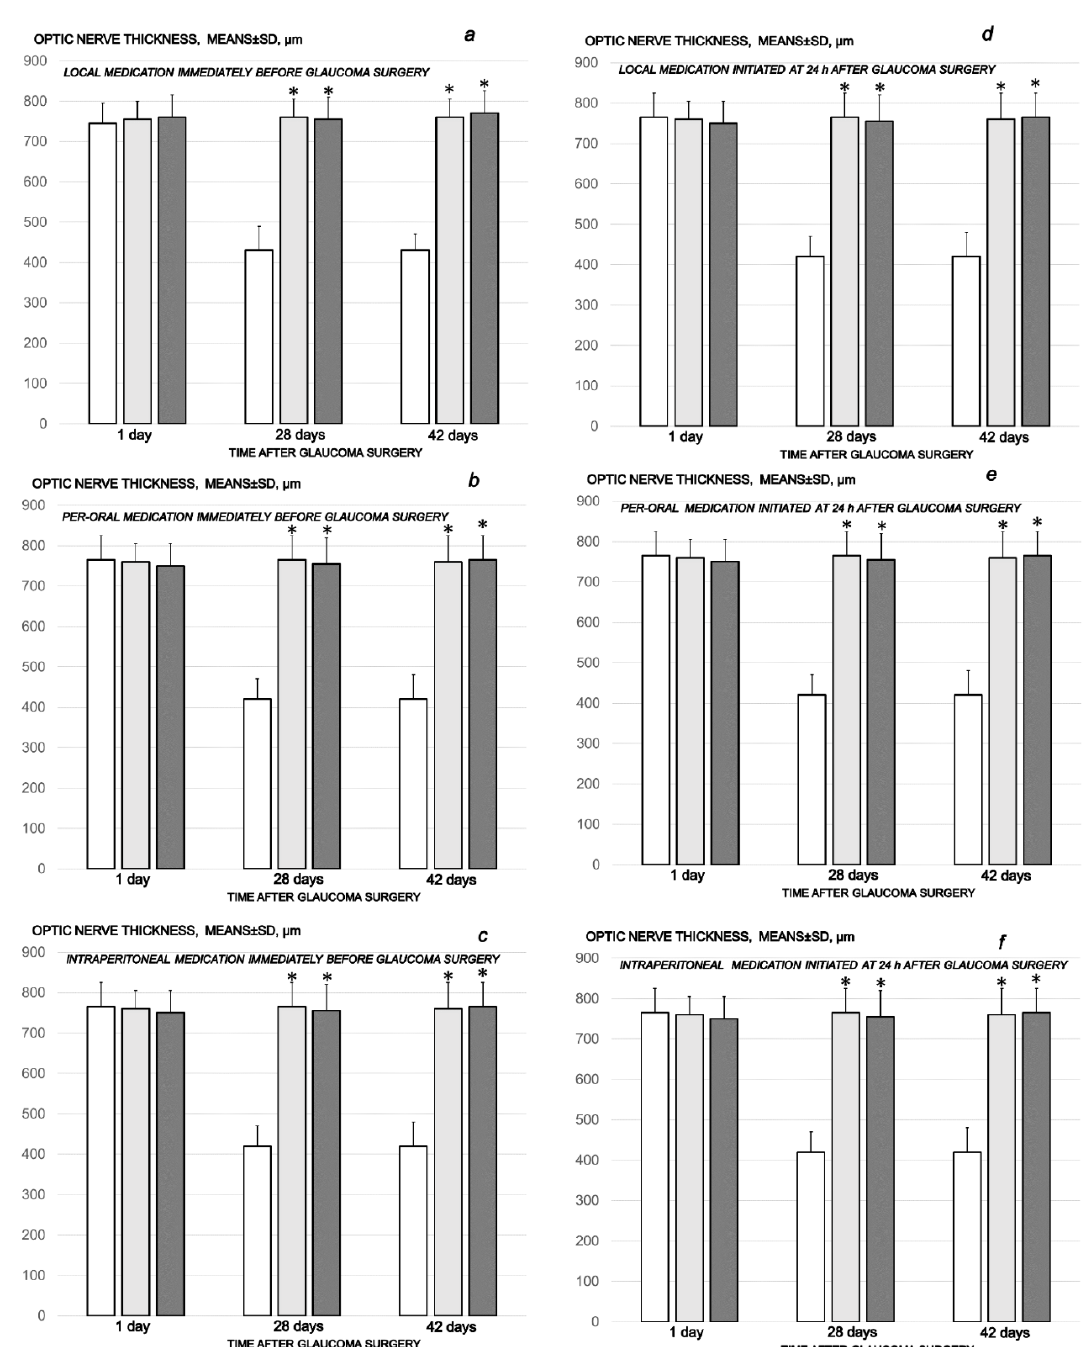
Figure 12. Cauterization of the three episcleral veins induced a decrease in optic nerve thickness, means ± SD, µ m, at the first post-operative day and at the end of the fourth and sixth post-injury week. Counteracting effect of BPC 157 medication daily regimen, prophylactic ( a – c ) or curative ( d – f ) (gray bars, light gray bars µ g-regimen, dark gray bars ng-regimen (0.4 µ g/eye, 0.4 ng/eye; 10 µ g/kg, 10 ng/kg) given locally as eye drops in each eye ( a , d ), intraperitoneally (last application at 24 h before sacrifice) ( b , e ) or per-orally in drinking water (0.16 µ g/mL, 0.16 ng/mL, 12 mL/rat until the sacrifice, first application given intragastrically) ( c , f )), started prophylactically (immediately before glaucoma surgery) or as curative treatment (at 24 h after glaucoma surgery). Controls (white bars) simultaneously received an equal volume of distilled water (two drops/eye), saline intraperitoneal application (5 mL/kg) or per-oral drinking water (12 mL/day/rat). * minimum p < 0.05 vs. control. A total of 6